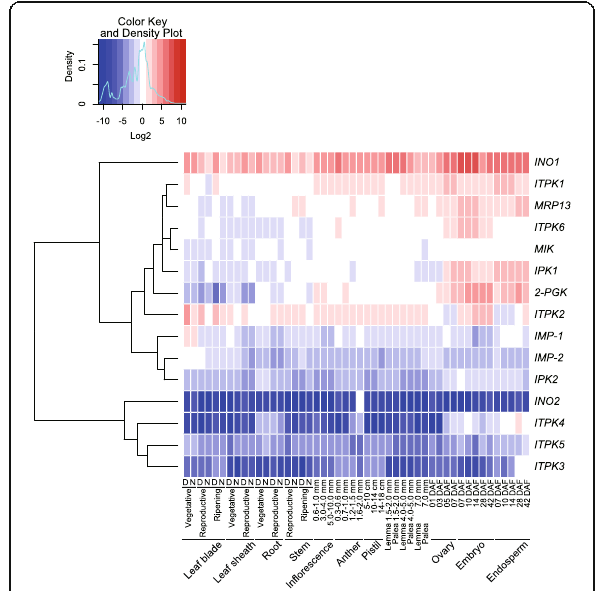
Fig. 3 Heat map of PA biosynthetic and transporter genes and their expression profiles among various organs at different developmental stages of the rice plant. A total of 15 PA-biosynthetic and transporter genes identified from the Rice Microarray database (RiceXpro) were analyzed by hierarchical clustering. A heat map was created using the spatio-temporal gene expression values of various organs throughout plant development in the field (Sato et al. 2013) with the heatmap.2 function from the gplot package in R (version 3.2.1). High expression values are shown in red. D; day, N; night, DAF; days after